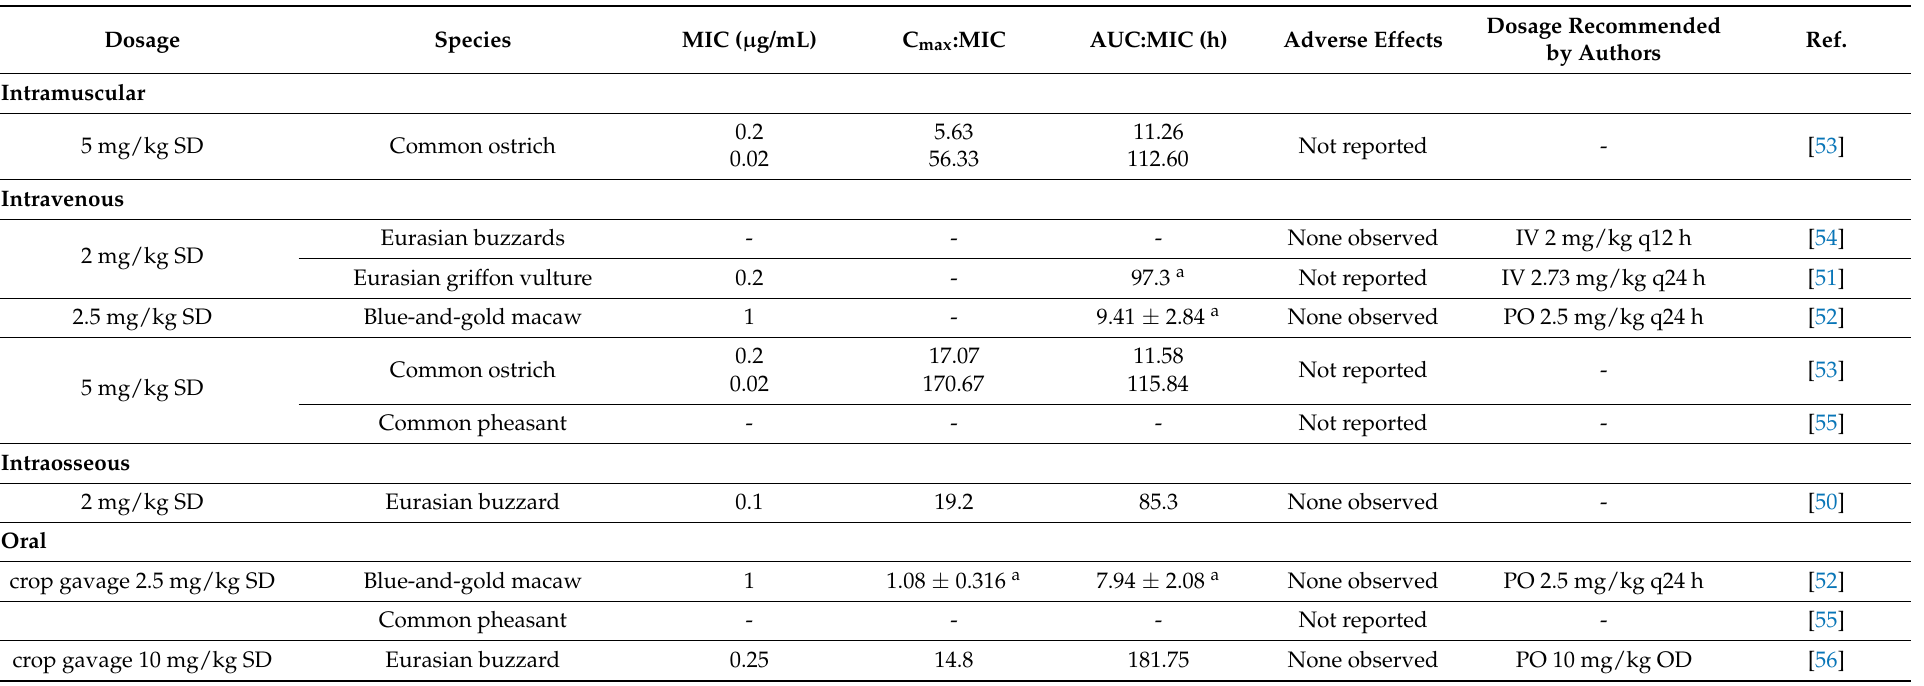
Table 4. Adverse effects, efficacy parameters, and dosage recommendations of marbofloxacin in exotic avian species.